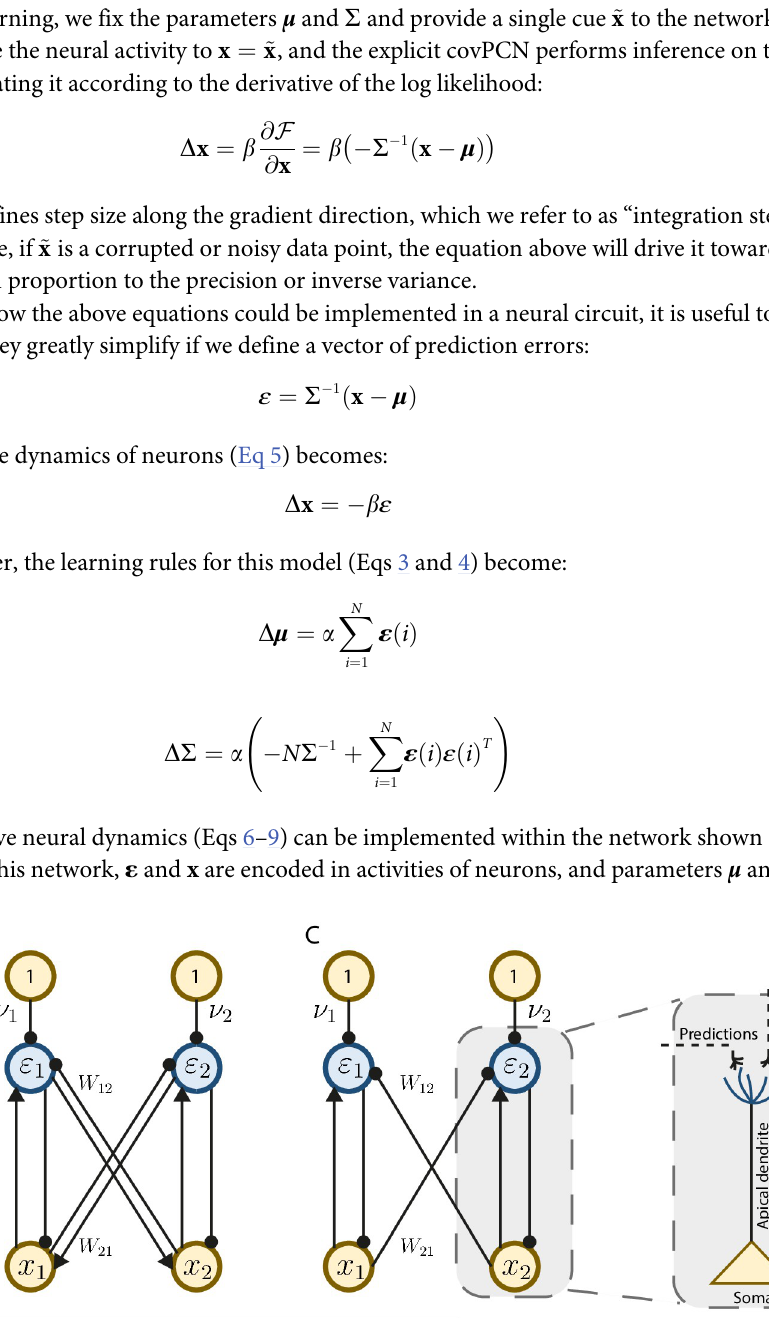
PLOS Computational Biology | https://doi.org/10.1371/journal.pcbi.1010719 April 14,